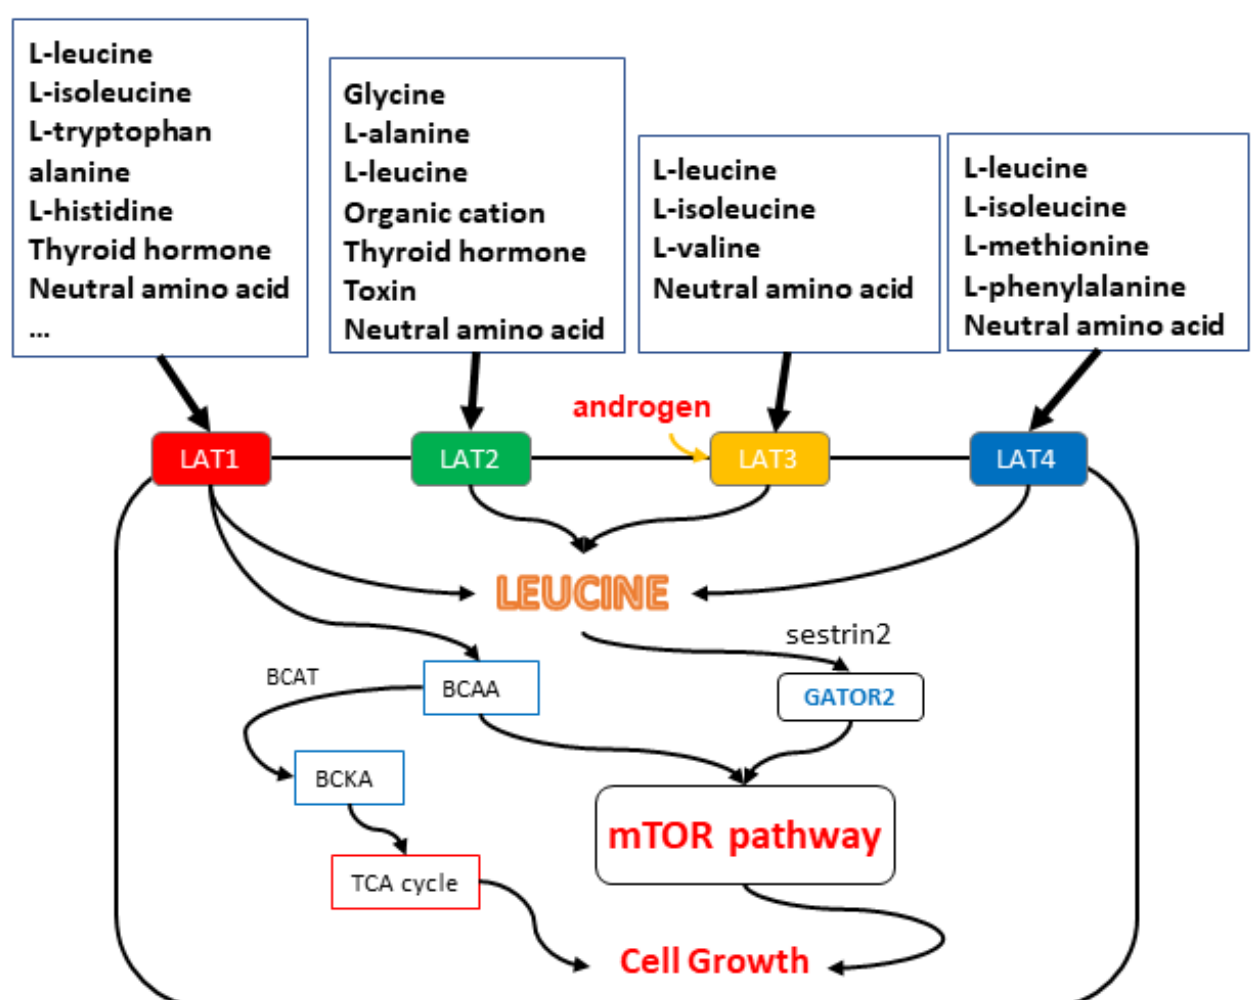
Figure 1. The substances that each LAT is mainly responsible for transporting are shown in the figure. LATs provide branched-chain amino acids (BCAA), especially leucine, to mammalian target cells of rapamycin complex 1 (mTORC1), and the mTOR pathway is a major control factor in cell proliferation. Leucine is transported into the cell by LATs, binds to the leucine sensor sestrin2, mTORC1 senses amino acid signal, and GATOR2 acts as mTORC1 agonist. Thus, it can promote the function of the mTOR pathway and achieve the purpose of cell proliferation. In addition, LAT1 can use BCAAs as biosynthetic materials for the metabolic reprogramming of cancer cells. BCAT deaminates free BCAAs to form BCKA. It enters the TCA cycle and is used for energy production and fatty acid metabolism to promote cell proliferation.